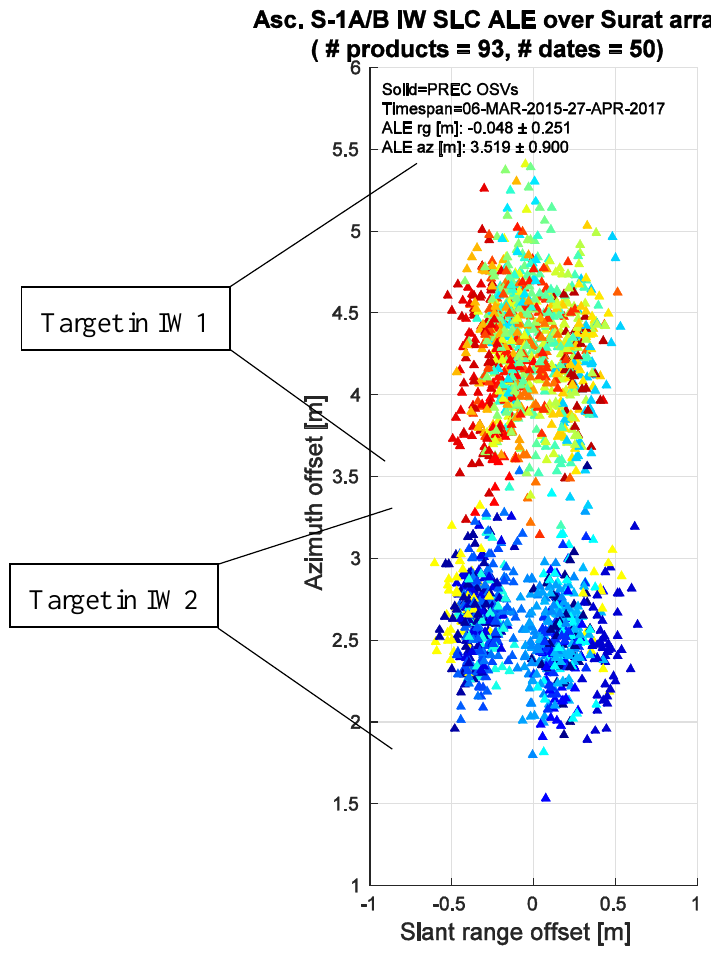
Figure 7. S-1 IW mode SLC product geolocation accuracy based on products over Australian Surat corner reflector array from 2015–2017 after correction of the GPS download error during the original survey. Colours indicate specific reflectors in the array.